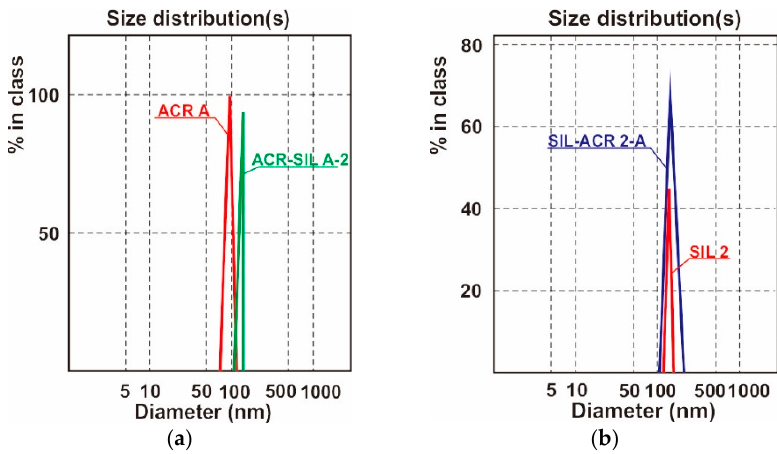
Figure 5. Comparison of particle size distribution patterns of hybrid ACR-SIL A-2 dispersion and starting ACR A dispersion ( a ) and of hybrid SIL-ACR 2-A dispersion and starting SIL 2 dispersion ( b ). X-axis is logarithmic.